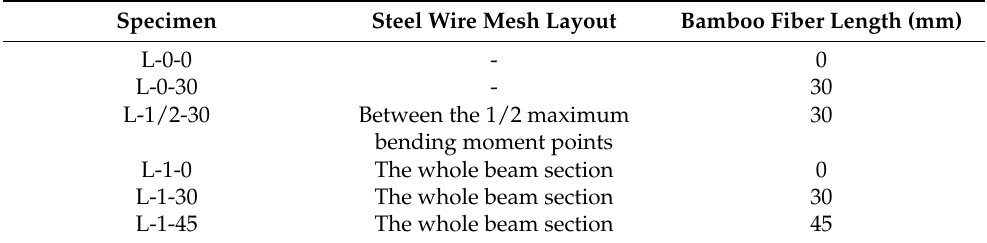
Figure 2. Reinforcement drawing of the section. Table 4. Parameters of the test